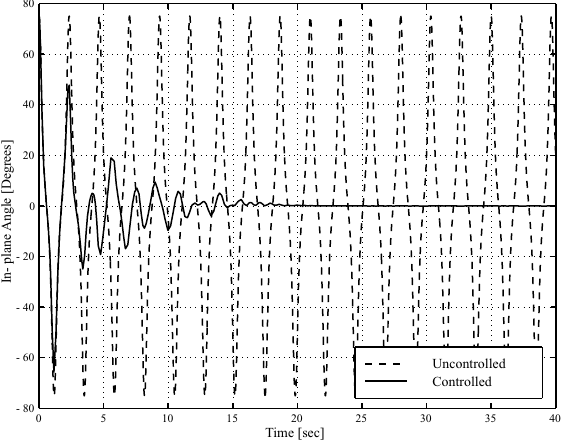
Fig. 25. Uncontrolled vs controlled in-plane oscillation angle φ ( t ) for the damping case using the fuzzy controller.